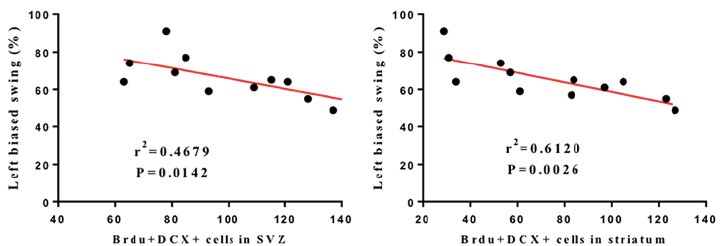
Figure 4. Pearson correlation between left biased swing at 28 days after MCAO and number of BrdU-positive/DCX-positive cells.